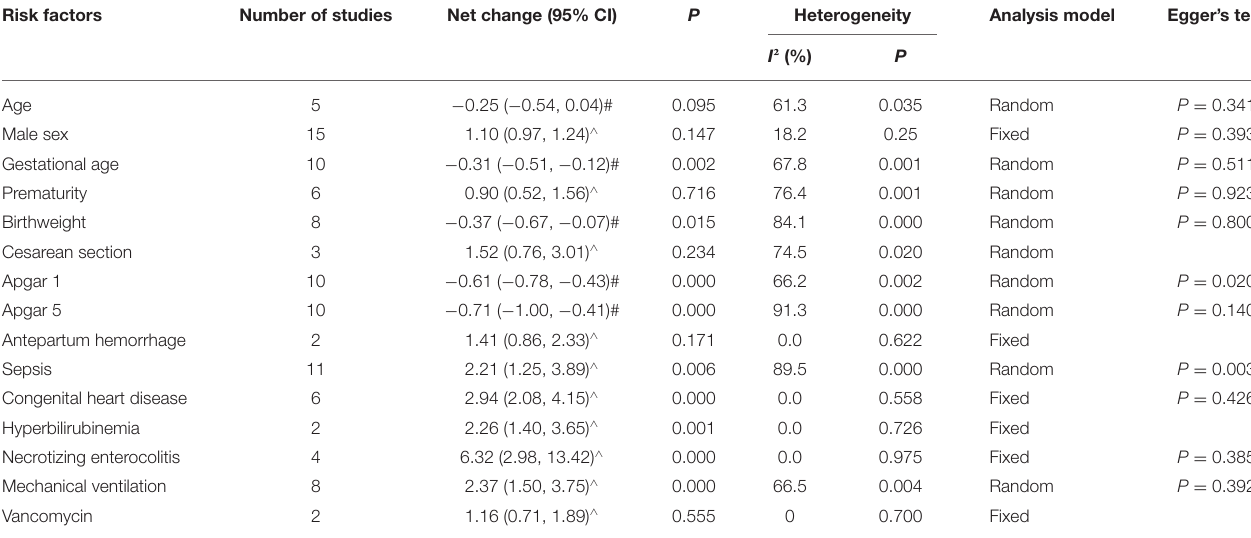
TABLE 5 | Results of meta-analysis.